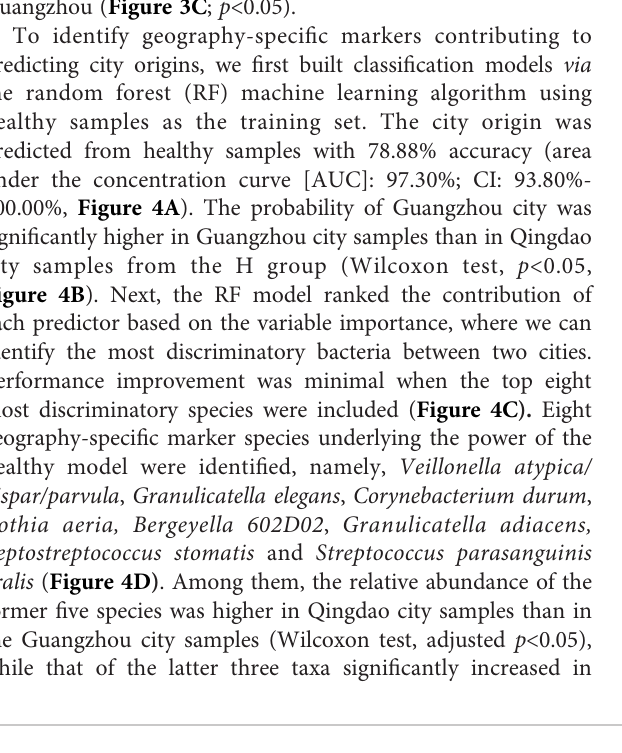
( Figure S6 ). Second, to test whether differences in oral microbiota in caries were consistent by city, we built RF models in each city (i.e., Qingdao and Guangzhou) and achieved diagnosis accuracies of 84.38% and 76.47%. Furthermore, training a diagnosis model in one dataset and applying it to another led to lower yet still decent and meaningful performance ( Figure S7 ). Speci fi cally, application